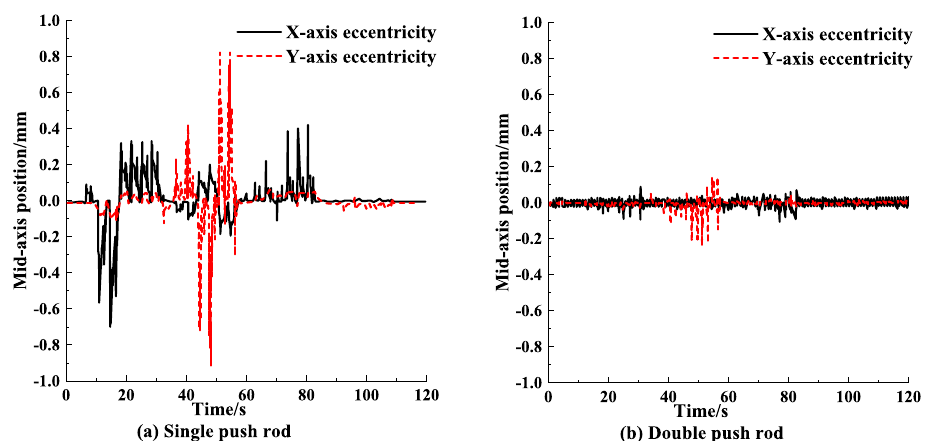
Figure 10. The displacement of the mid − axis of the single push rod support adjustment mechanism, double push rod − double spring support adjustment mechanism under casing reduction obstacle.